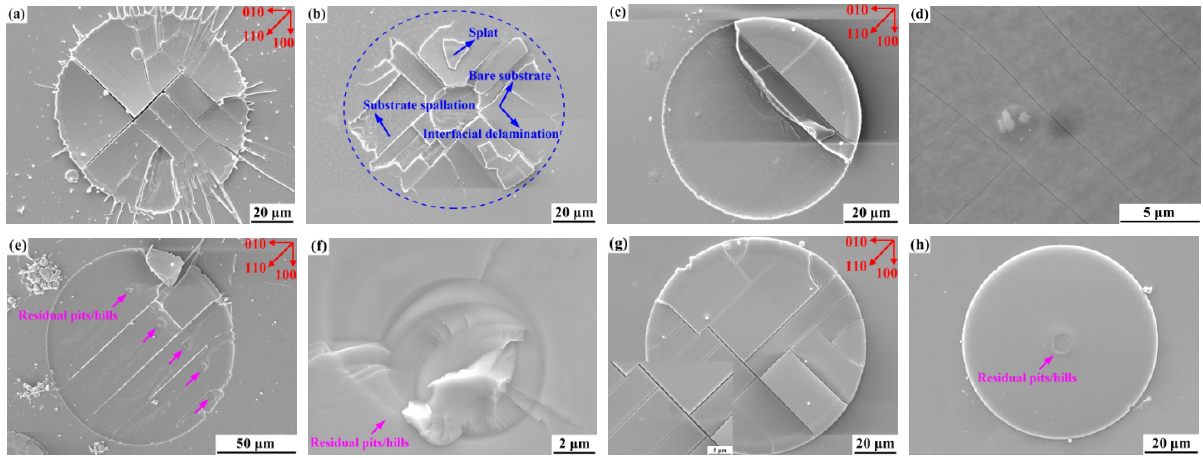
Fig. 3 Surface morphologies of 7YSZ splats at the deposition temperature of (a, b) 100, (c, d) 300, (e, f) 400, and (g, h) 600 ℃ . All crack patterns present regular morphologies. Intact splat without vertical cracks is clearly observed (h). The red arrows denoted the detailed crystallographic orientation. The dash blue circle in (b) showed the outline of splat. The pink arrows in (e), (f), and (h) represented the residual